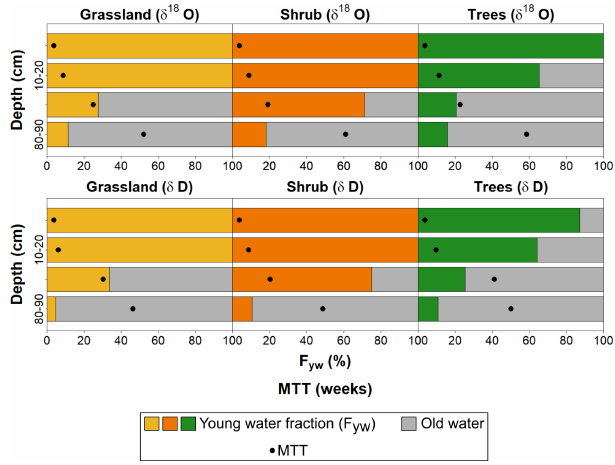
Figure 8. F yw and MTTs at different sites and depths (0–10cm, 10–20cm, 40–50cm and 80–90cm) during the growing period of